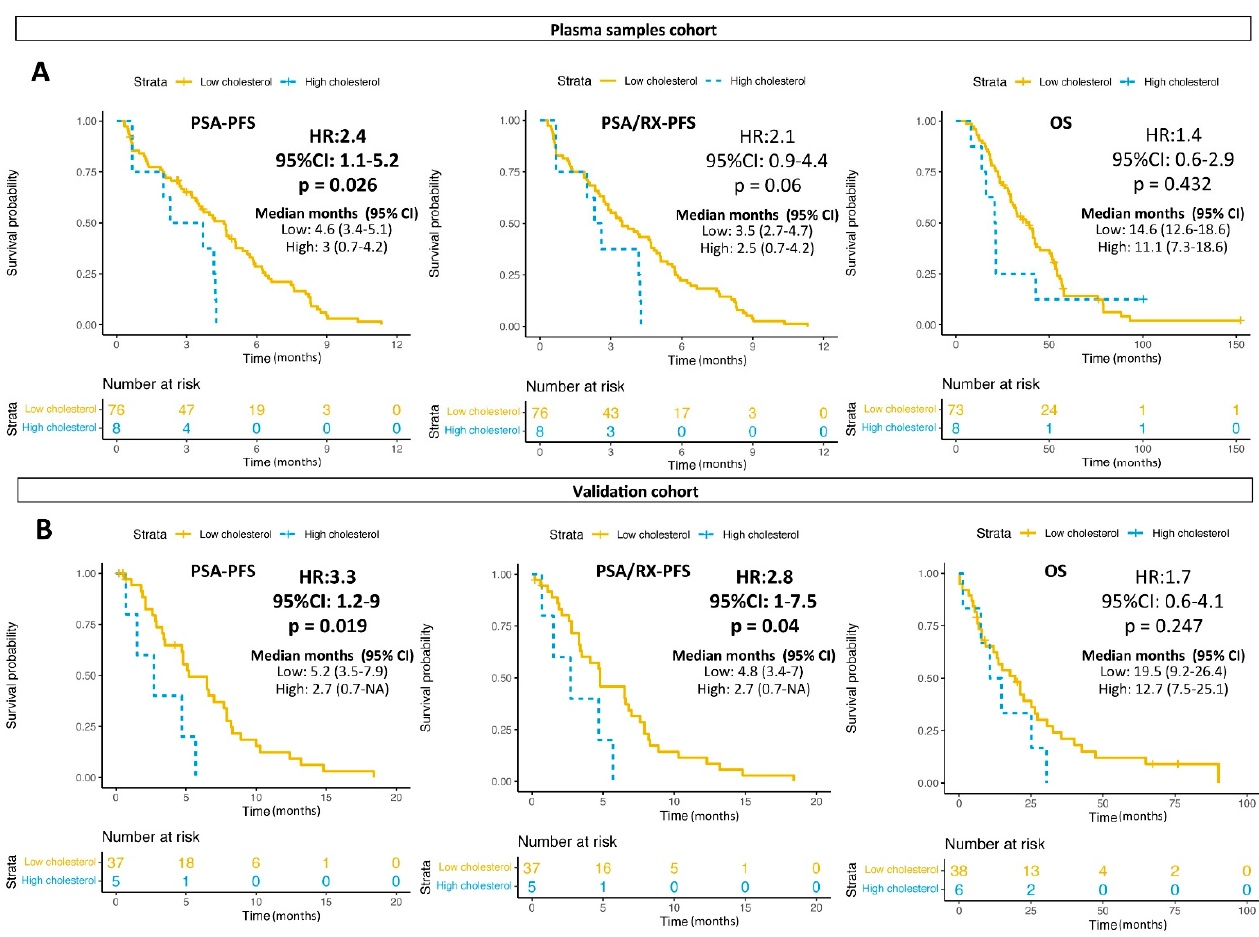
Figure 5. Cholesterol levels and clinical outcomes. ( A ) Kaplan–Meier curves representing PSA-PFS, PSA/RX-PFS and OS according to the cholesterol levels in the plasma samples cohort. ( B ) Kaplan–Meier curves representing PSA-PFS, PSA/RX-PFS and OS according to cholesterol levels in a validation cohort. Cut-off for the cholesterol levels was the one used at the routine blood test analysis (247 mg/dL). CI: confidence interval; HR: hazard ratio; Wald test ( p ); Time is in months.